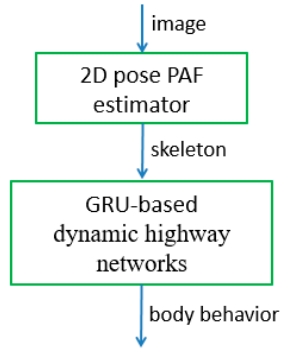
Figure 5. Illustration of body behavior-recognition model.